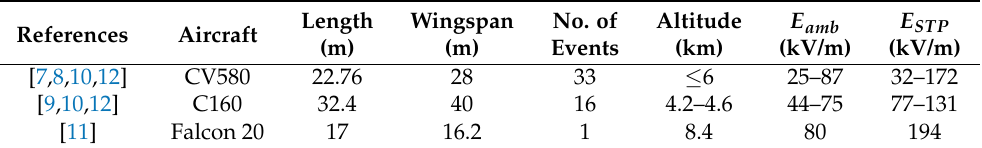
Table 3. Ambient electric fields measured before lightning initiation ( E amb ) from different instru- mented aircraft. Corresponding E STP values are the corrected ambient fields at STP which are directly quoted from the respective